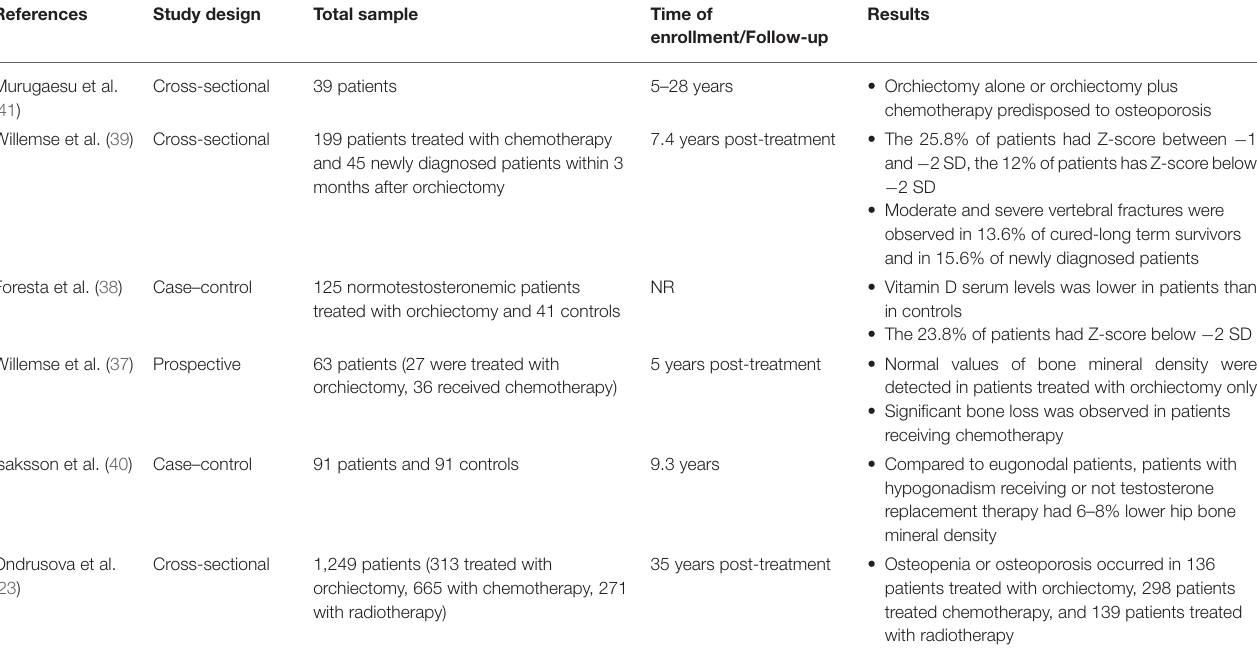
TABLE 4 | Summary of available data from studies on bone mineralization in testicular cancer